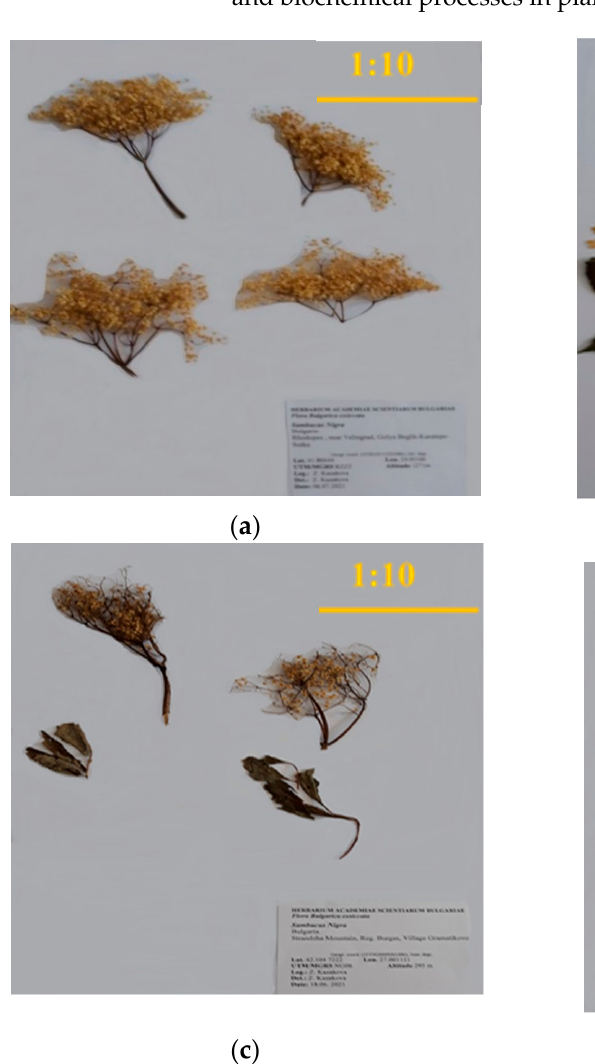
Table 2. Necessary data for the identification of the studied plant species. Plant Mate- rial/Herbs/, Identifi- cation Number